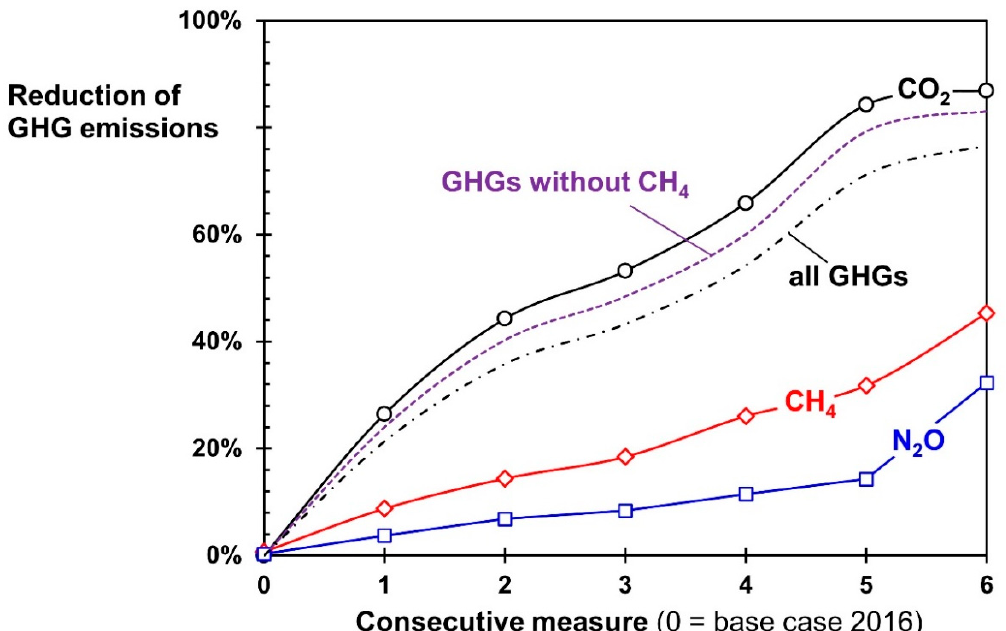
Figure 5. Reduction of global GHG emissions (CO 2 , CH 4 , N 2 O, without F-gases for different consecutive measures (constant global population and prosperity).